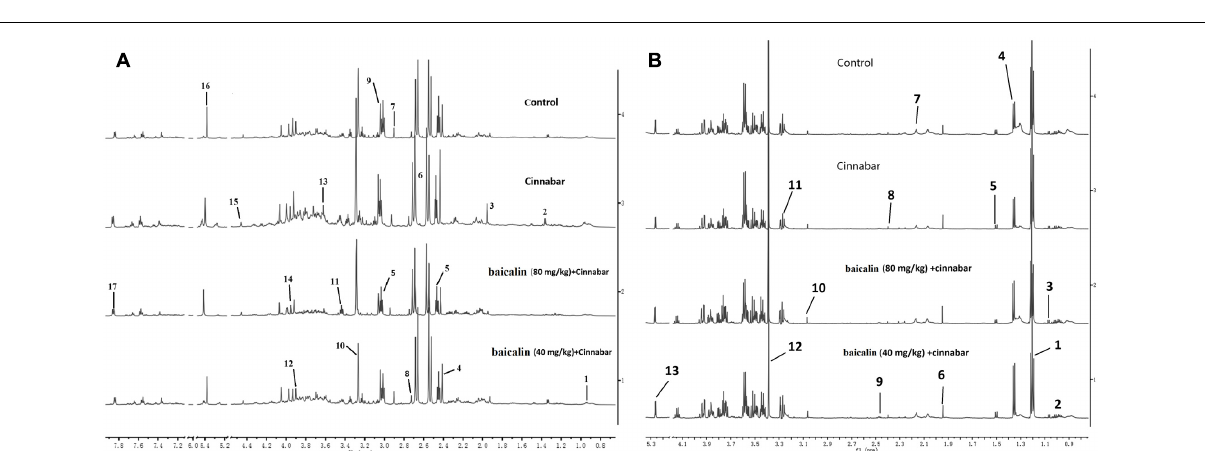
FIGURE 2 | Kidney and liver histopathology of rats: Liver: control (A) ; cinnabar (B) ; LBC group (C) ; HBC group (D) ; Kidney: control (E) ; cinnabar (F) ; LBC group (G) ; HBC group (H) . Inside the red circle, (B) spotty necrosis. (C) Hepatic sinusoidal edema (F) glomerular atrophy, lobulated.